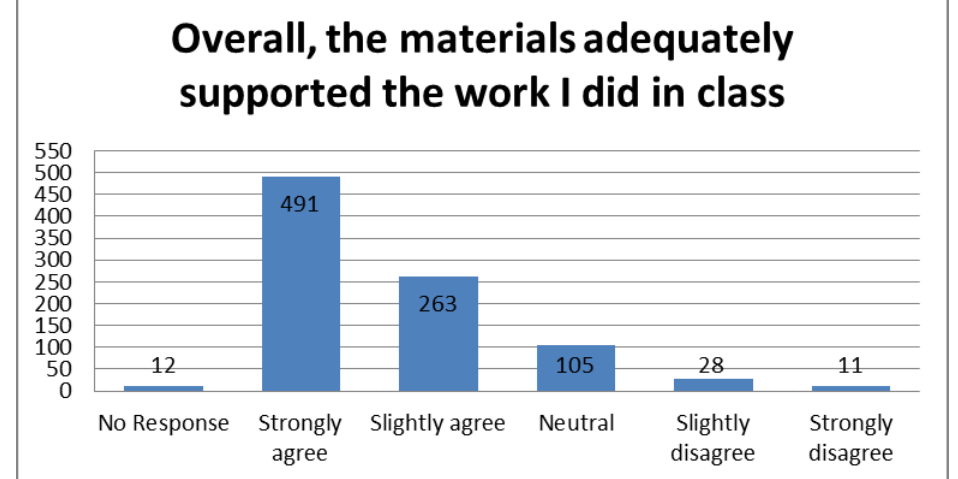
Figure 1 . Student responses to the statement, “Overall, the materials adequately supported the work I did in class.”